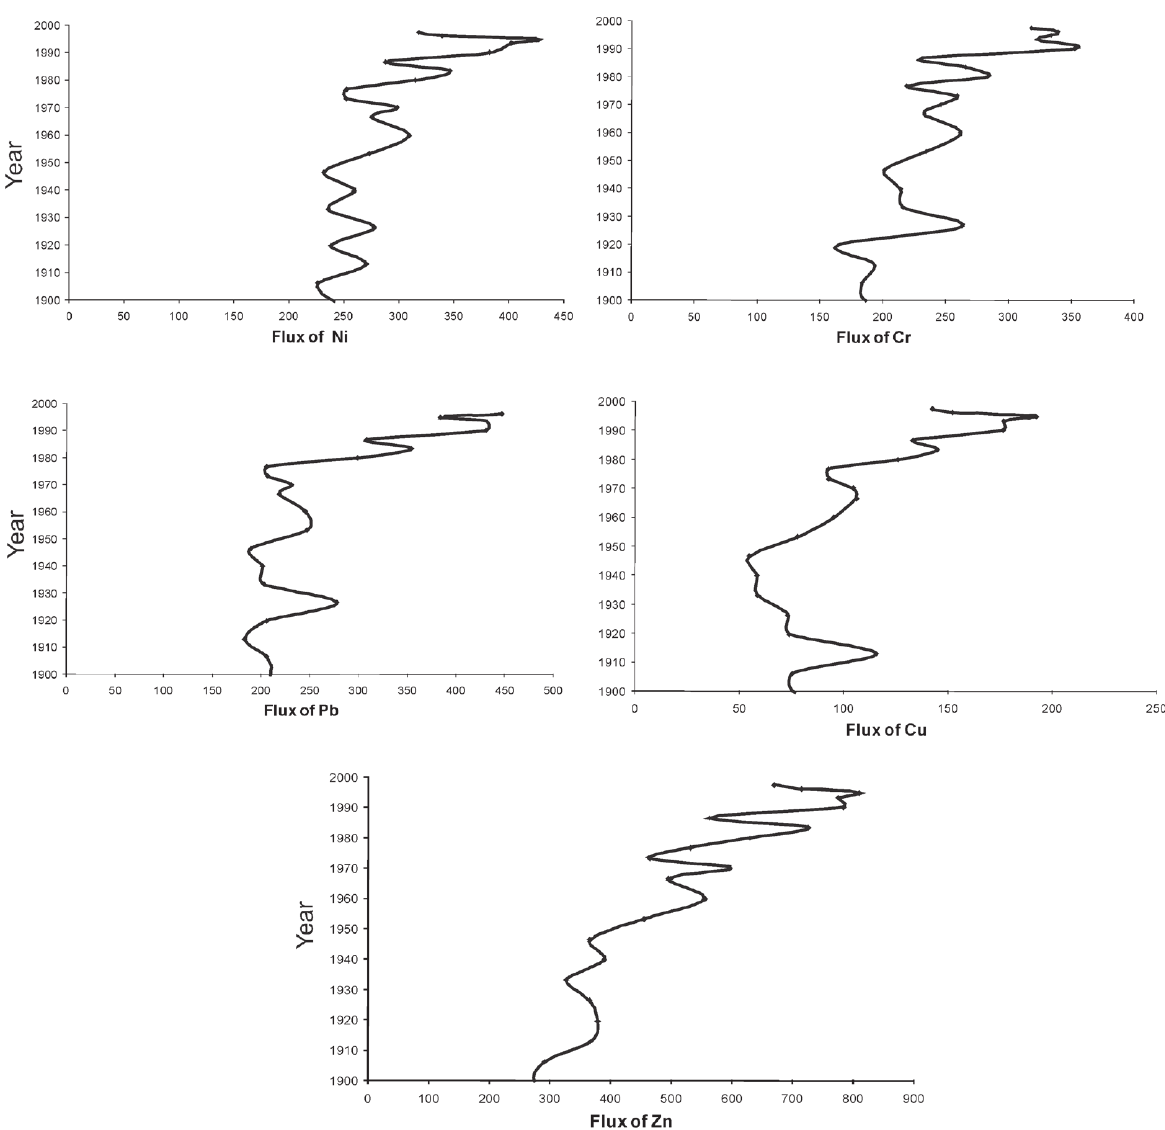
Figure 5 - The profile of (a) Ni (g.Ni.m -2 .year -1 ), (b) Cr (g.Cr.m -2 .year -1 ), (c) Pb (g.Pb.m -2 .year -1 ), (d) Cu (g.Cu.m -2 .year -1 ) and (e) Zn (g.Zn.m -2 .year -1 ) concentrations over time in the sediment